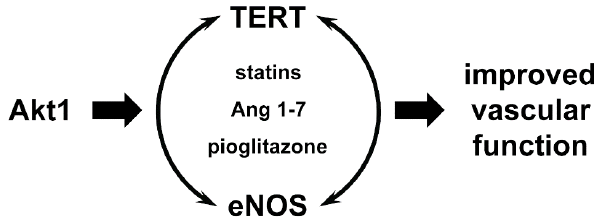
Figure 2. Interconnection between TERT and eNOS. TERT and eNOS mutually reinforce their activities in the endothelium. One common upstream regulator is Akt1. Statins, Angiotensin 1-7 (Ang1-7) and pioglitazone increase not only NO production, but also Telomerase activity.